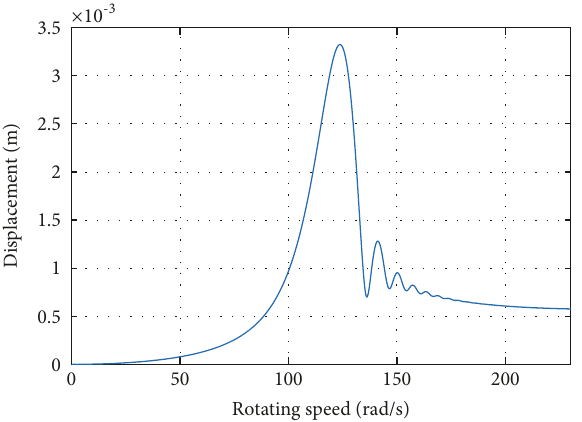
Figure 2: Deterministic accelerating of transient response of the